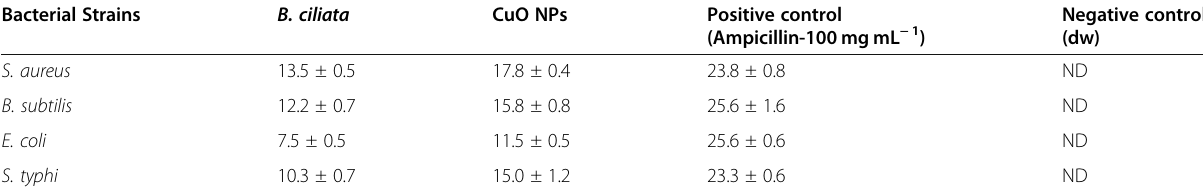
Zones of inhibition (mm) are presented as mean±SD. S. aureus= Staphylococcus aureus ; B. subtilis = Bacillus subtilis; E. coli = Escherichia coli, S. typhi = Salmonella typhi. Amp=Ampicillin (positive control); ND (not